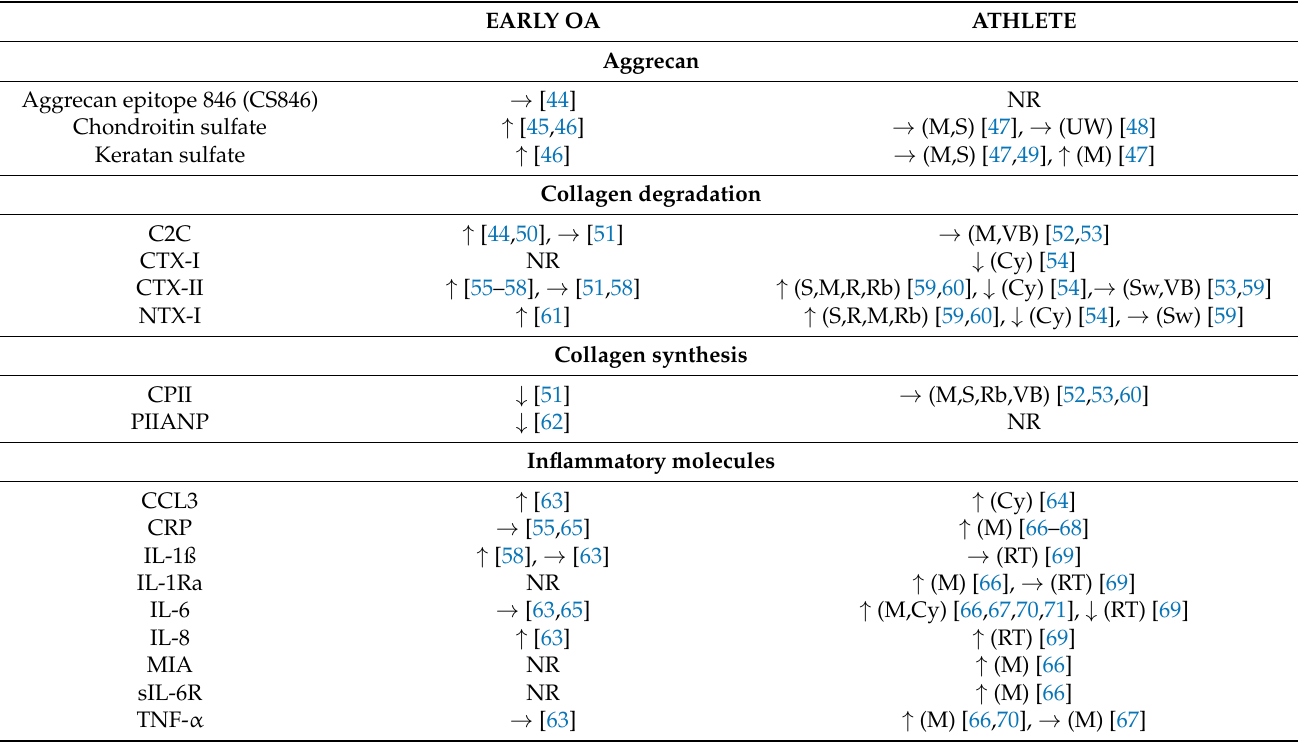
Table 1. Fluid biochemical markers of knee early osteoarthritis and of exercise/training in athletes. EARLY OA